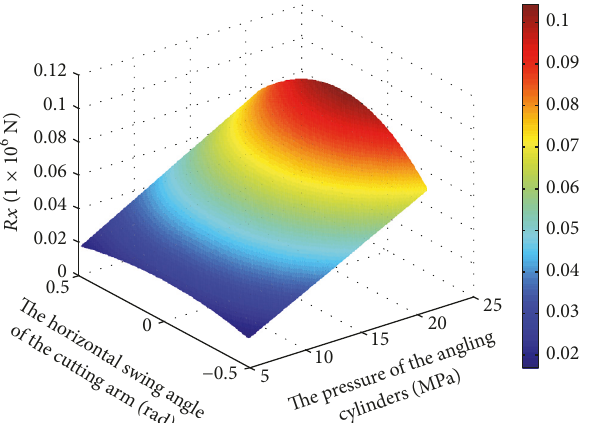
Figure 6: The component force 𝑅 𝑋 of the cutting head load in the horizontal direction.